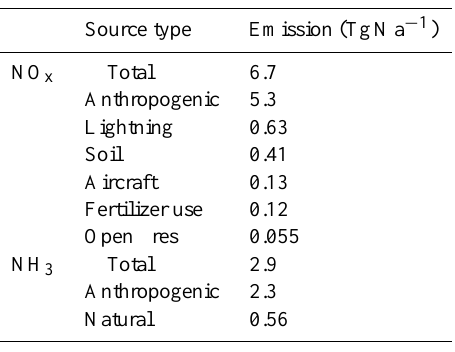
Table 2. NO x and NH 3 emissions over the contiguous US a